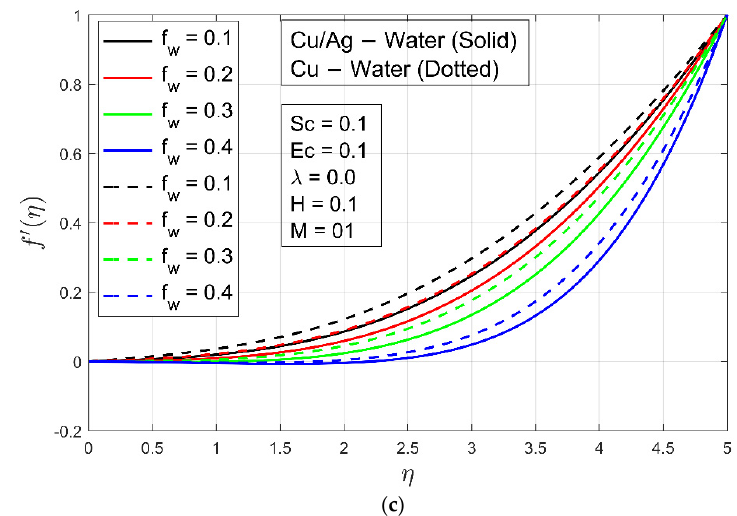
Figure 3. ( a ) Impact of stretching λ > 0 on velocity profile f (cid:48) ( η ) . ( b ) Impact of shrinking λ < 0 on velocity profile f (cid:48) ( η ) . ( c ) Impact of f w on velocity profile f (cid:48) ( η ) .